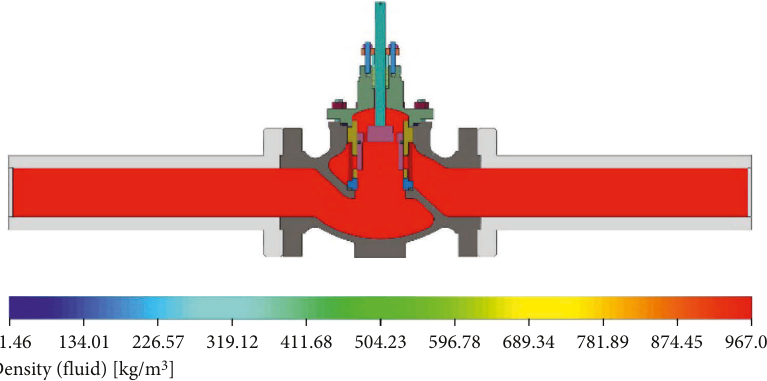
Figure 27: Fluid density cloud map for 40% opening.